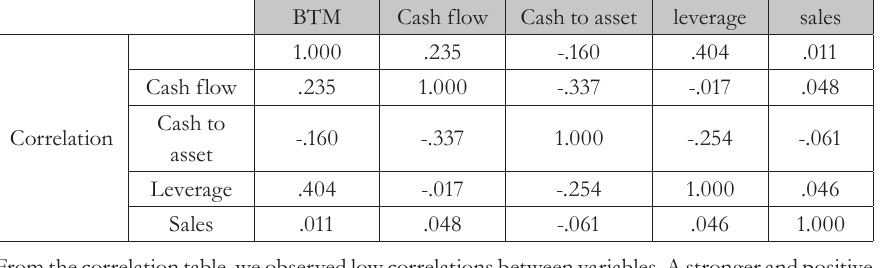
Tab. 1 – Correlation matrix between